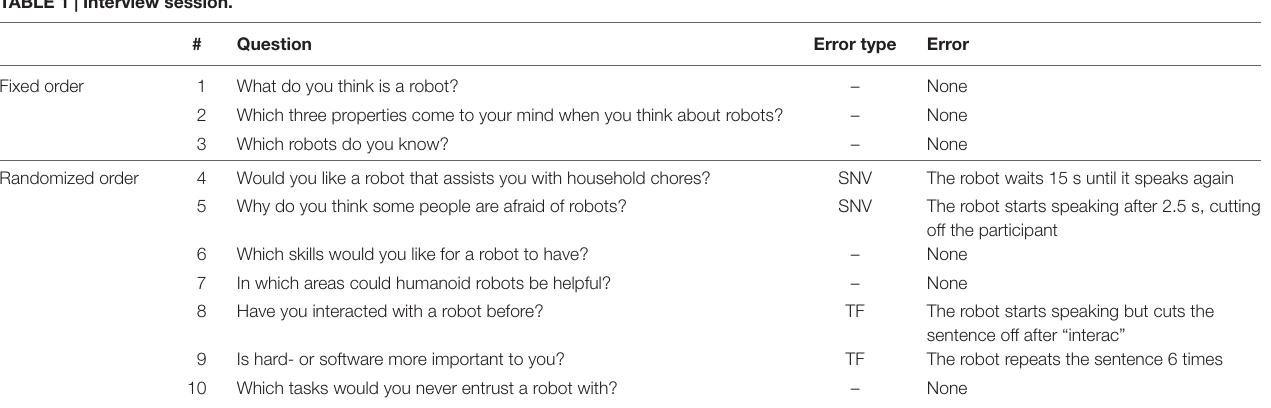
Table 1 | interview